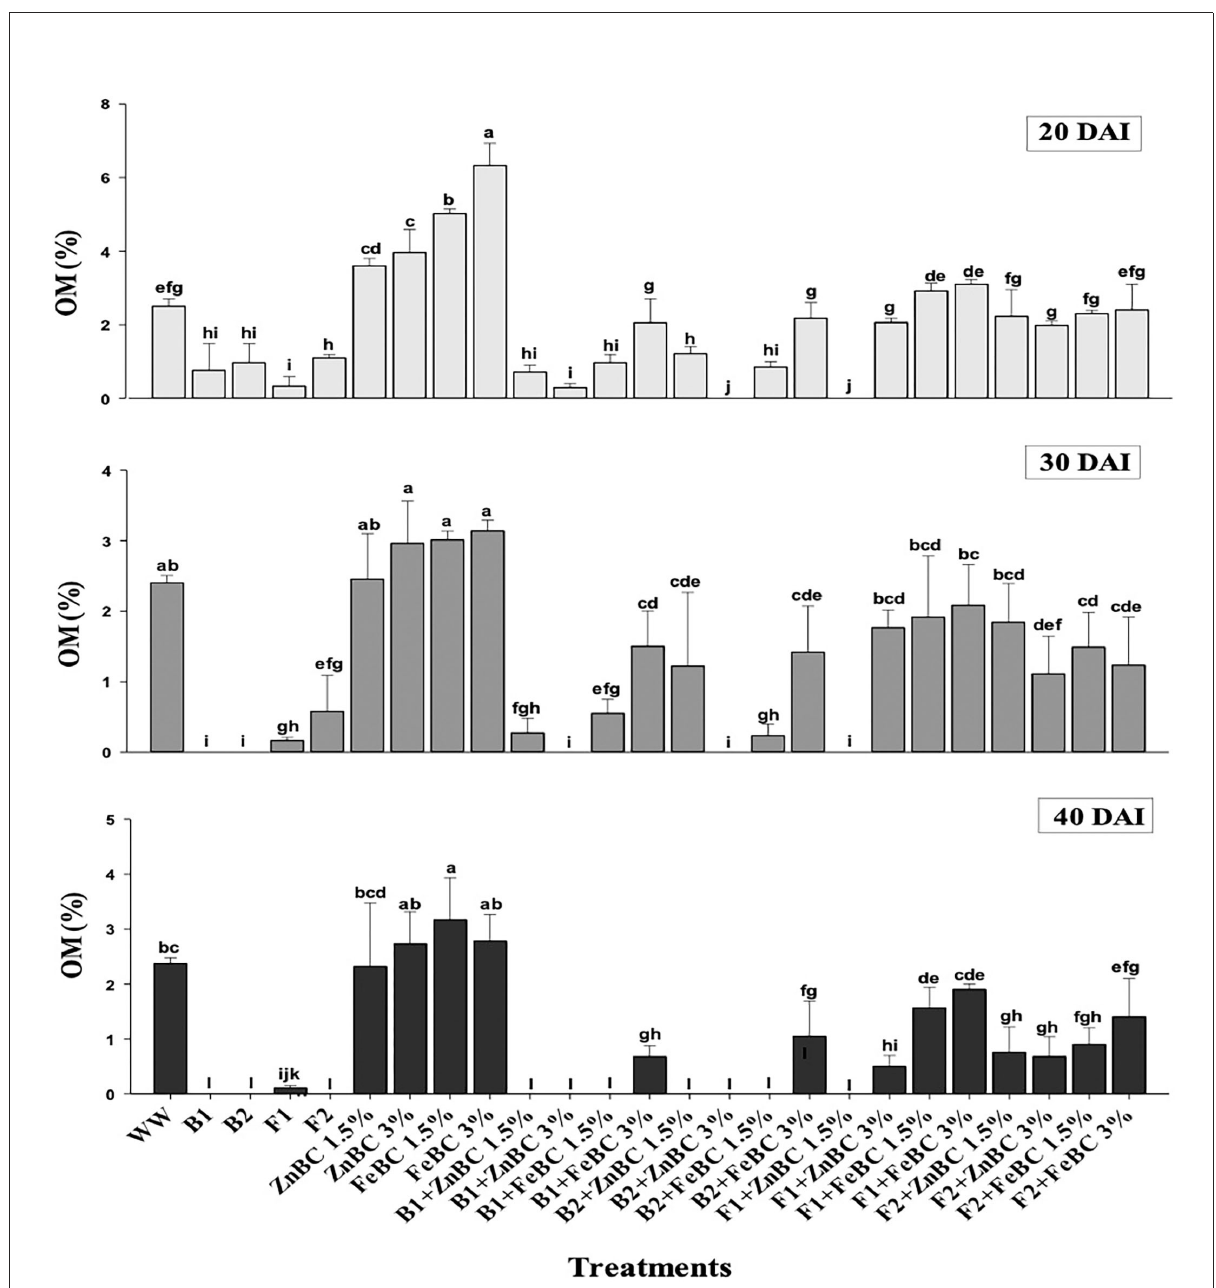
FIGURE6 Comparative analyses of OM% content for treatments (Mean ± S.D) at 20, 30, and 40 DAI periodic